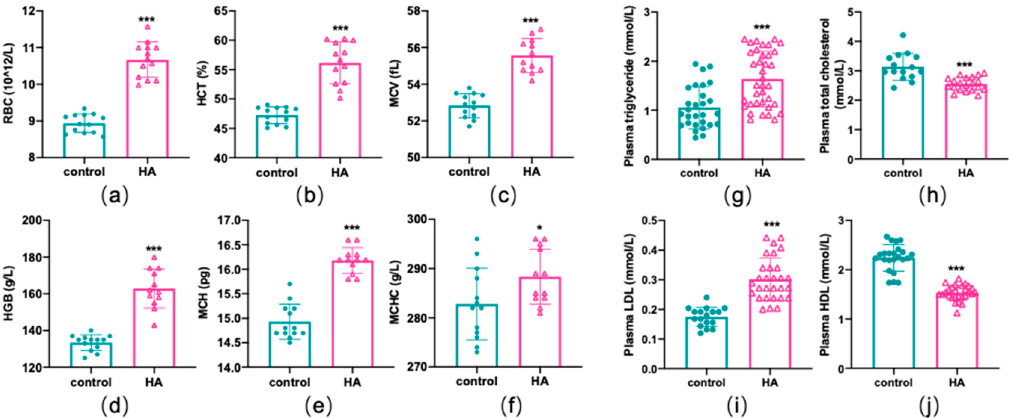
Figure 1. Hematological parameters and lipid profile differences induced by HA exposure. Graphs ( a – f ) display changes in hematological parameters. Graphs ( g – j ) display changes in lipid profiles. Data are presented as mean ± SEM of 12 mice. * p < 0.05 and *** p < 0.001 when compared with the control